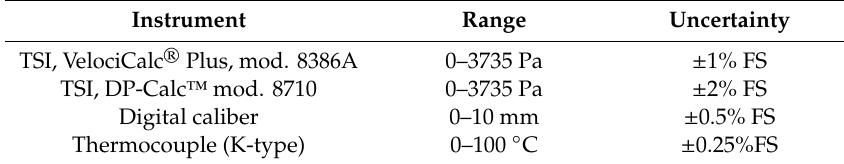
Table 1. Characteristics and uncertainties of the measurement instruments. Instrument